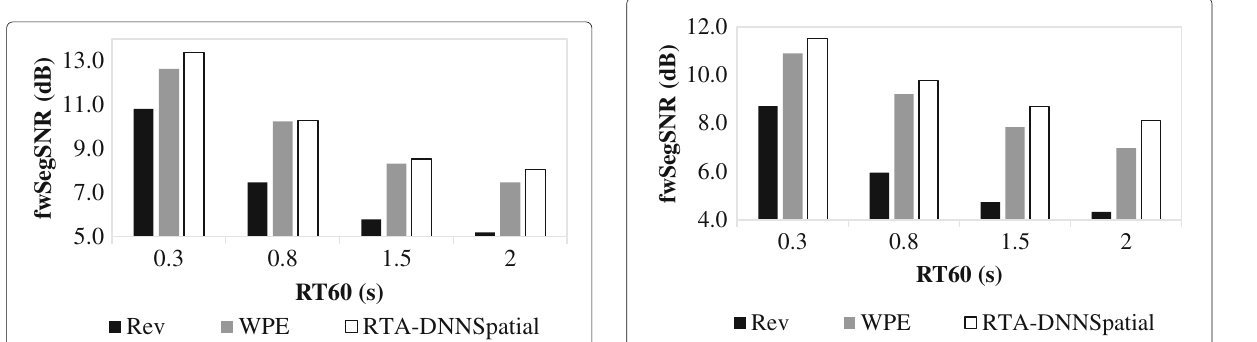
Fig. 10 Average fwSegSNR results at different RT60s, tested in a new room